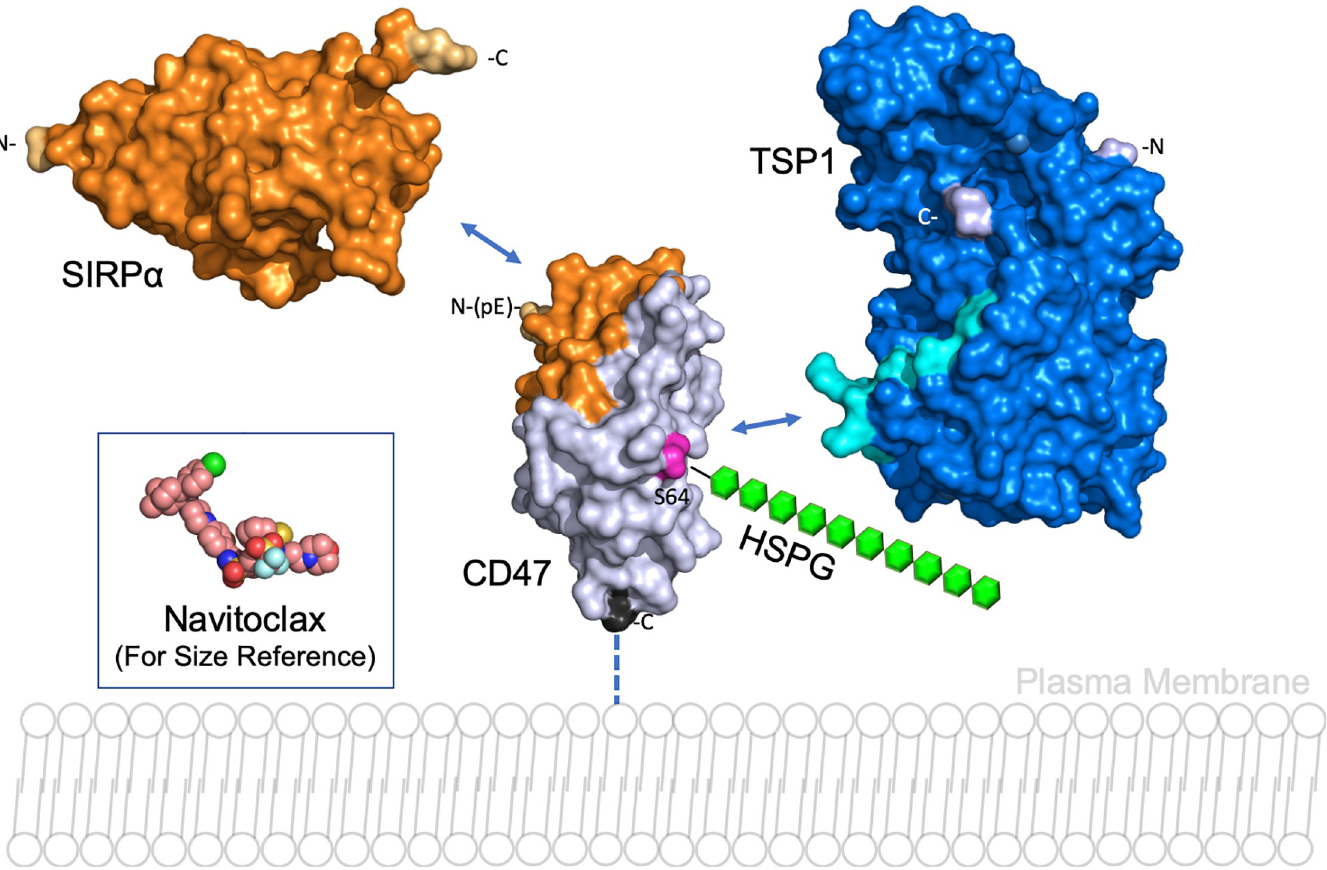
Fig 1. SIRP α and TSP1 interaction with CD47. The SIRP α -CD47 interface is defined by the co-crystal structure (PDB 2JJT) and is represented on the extracellular domain surfaces of CD47 (residues 20–136; gray) and SIRP α (residues 31–149; orange). The TSP1 interaction with CD47 is not well-defined but depends on a heparan- sulfate proteoglycan modification (HSPG; green) at CD47 Ser64 (magenta) and can be functionally minimized to the TSP1 peptide known as 7N3 ( 1120 FIRVVMYEGKK 1130 , light blue) shown on the surface of the C-terminal CD47-interacting domain of TSP1 (E3CaG1; PDB 1UX6; residues 834–1170; blue). As a molecular size reference, the clinical stage protein-protein interaction (PPI) inhibitor navitoclax (974.6 Da) is shown (PDB 4LVT). PPI inhibitors are generally larger small molecules, and navitoclax is roughly 2x the mass of a typical small molecule drug. The N- and C-termini of the constructs are